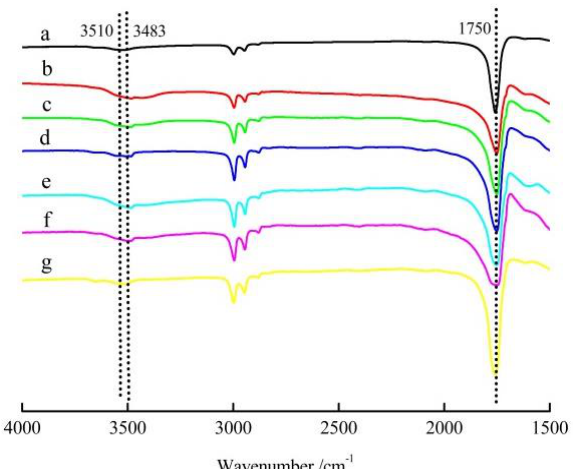
Figure 4. FT-IR spectra of PLLA, PDLAG-5%, and sc-PLAG samples in carbonyl region and hydrogen-bond region, a. PDLAG-5%; b. sc-PLAG-5%; c. sc-PLAG-4%; d. sc-PLAG-2%; e. sc-PLAG-1%; f. sc-PLAG-0.5%; g. PLLA.